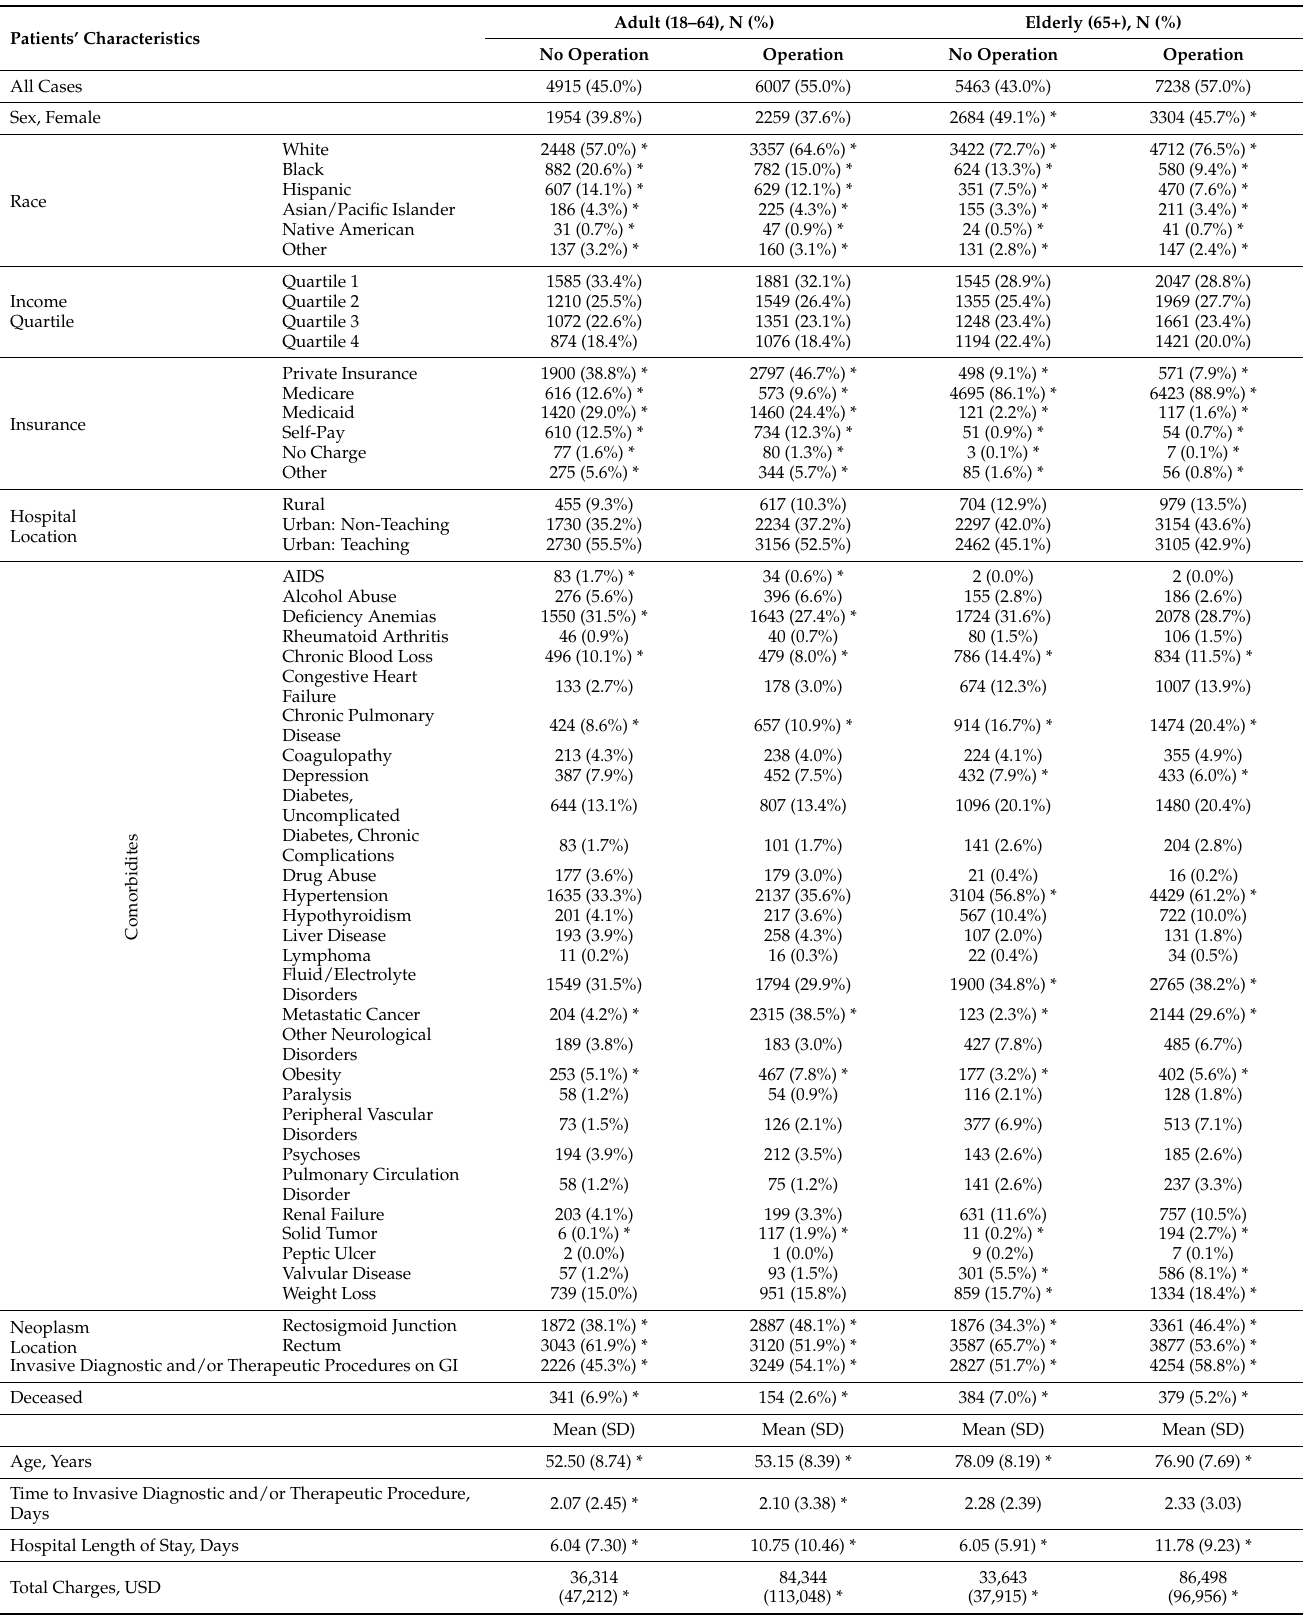
Table 4. Characteristics of emergency admitted patients with the primary diagnosis of malignant neoplasm of rectum or rectosigmoid junction. Data (NIS 2005–2014) were stratified according to surgery status. * p <